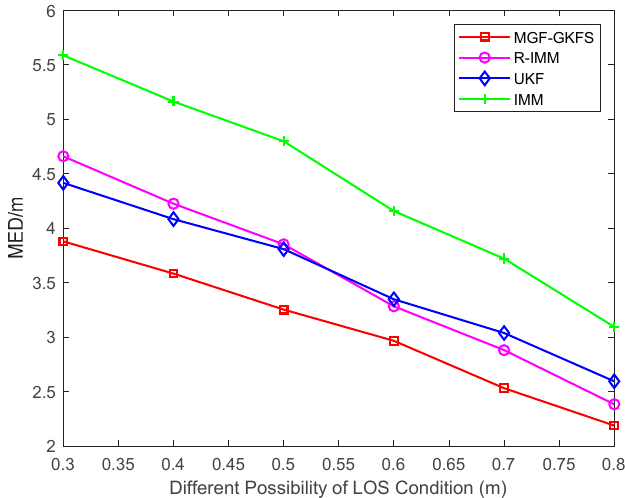
Figure 8. The MED versus different possibilities of LOS condition.